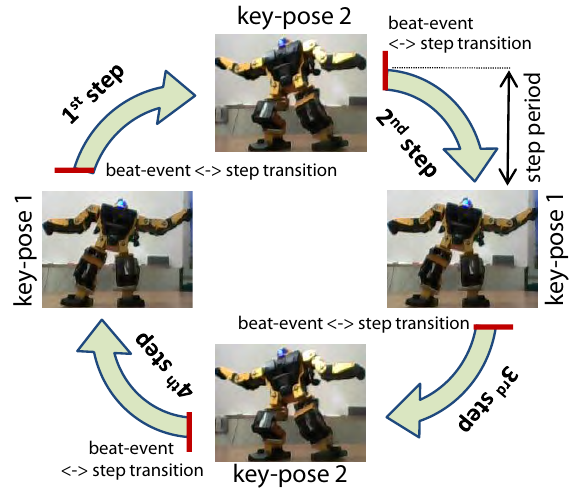
Figure 3: Dance movement composition. During performance, the subsequent movements are always randomly selected from the DL by the RC at the end of each movement cycle ( i.e. , after a set of four consecutive